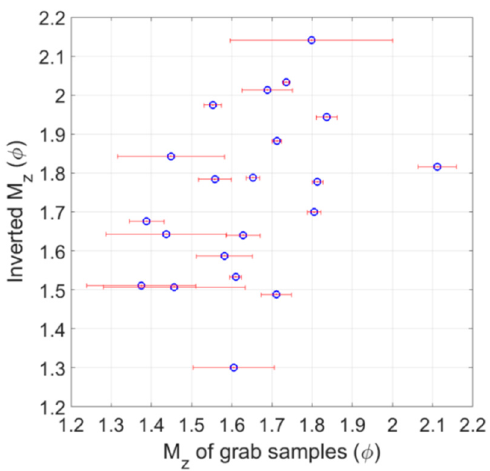
Figure 10. Averaged (over three replicates) mean grain size and standard deviation of grab samples versus their corresponding inverted values using optimization method.